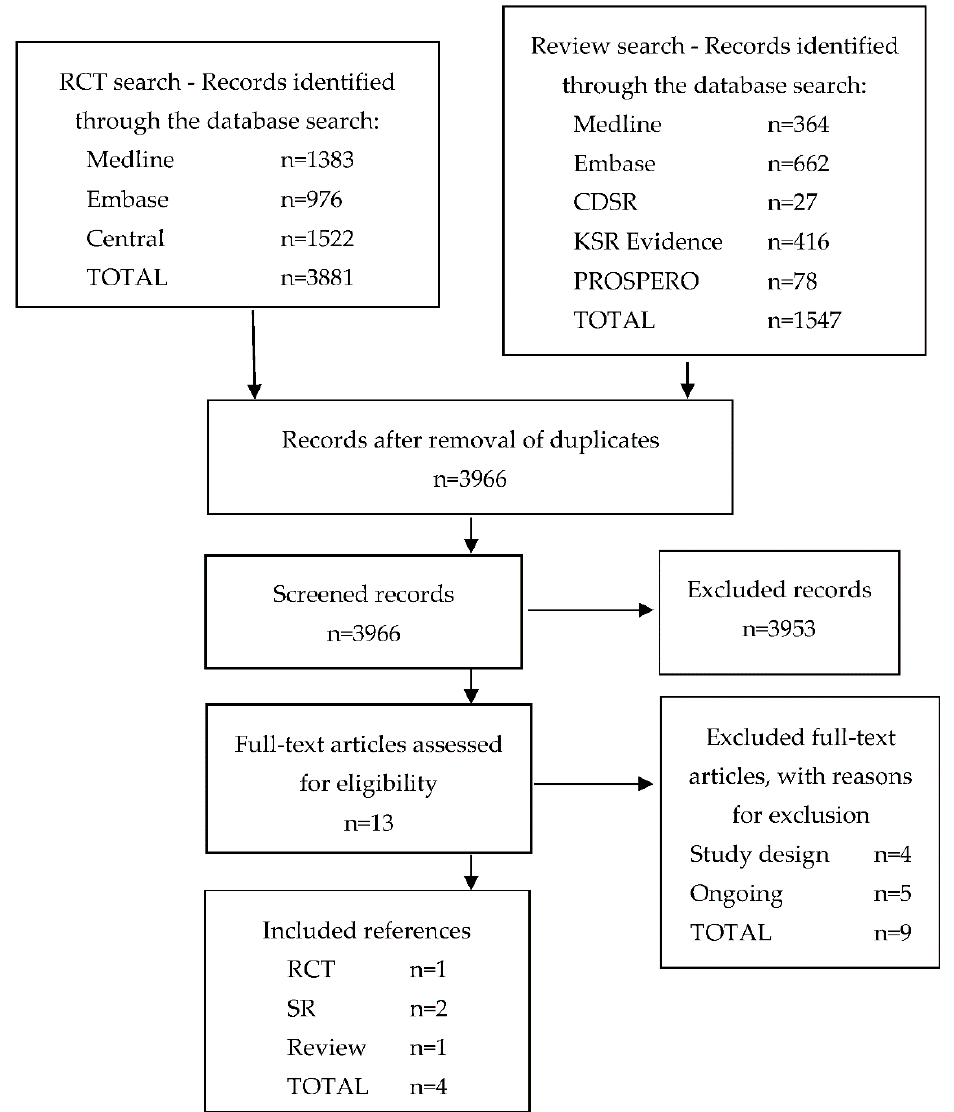
Figure 1. Flow chart—selection process. CDSR = Cochrane Database of Systematic Reviews; KSR = Kleijnen Systematic Reviews; NMA = network meta-analysis; PROSPERO = International Prospective Register of Systematic Reviews; RCT = randomized controlled trial; SR = systematic review.